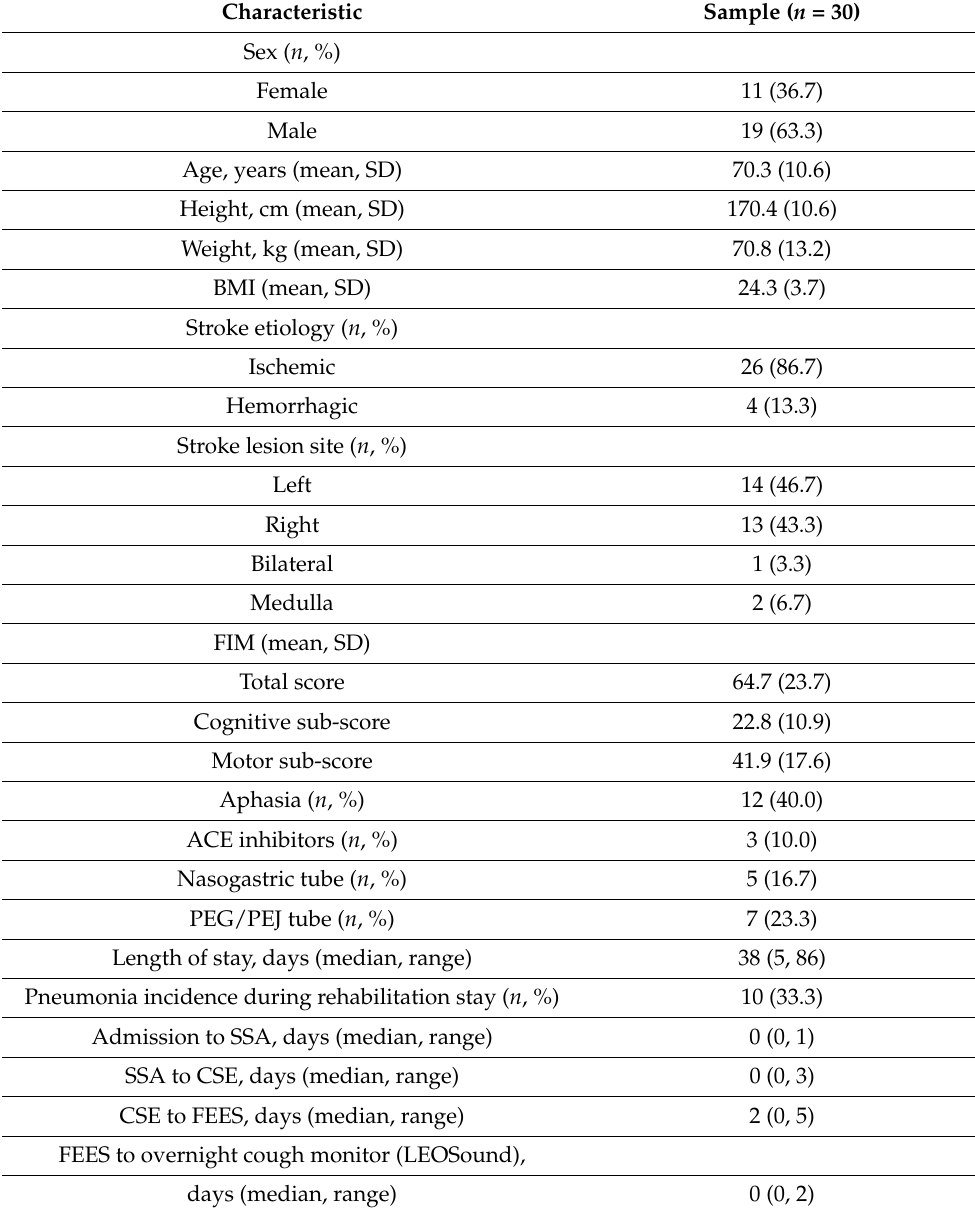
Table 1. Participant